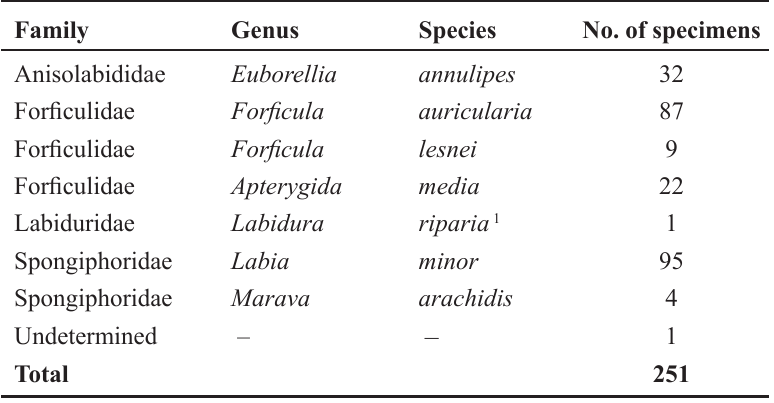
Table 3. Number of Dermaptera specimens in the British Collection of the Manchester Museum, by species.